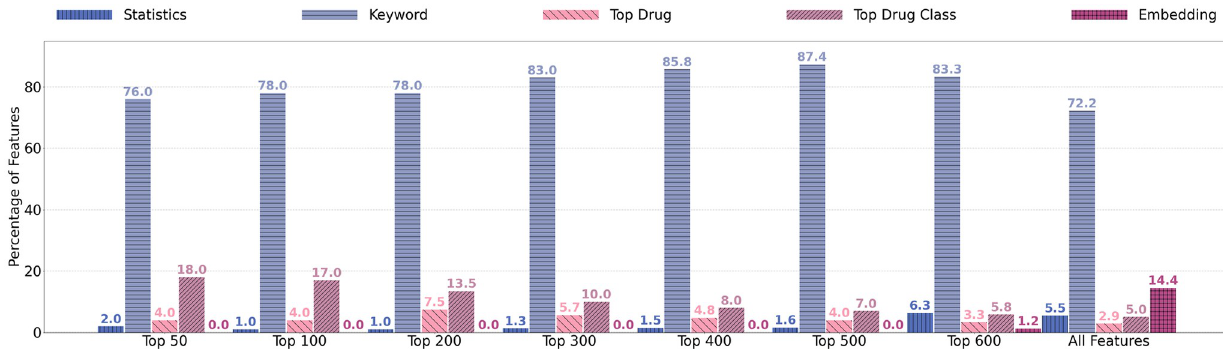
Fig 11. Percentage of types of features within the top ranked 50–600 and all